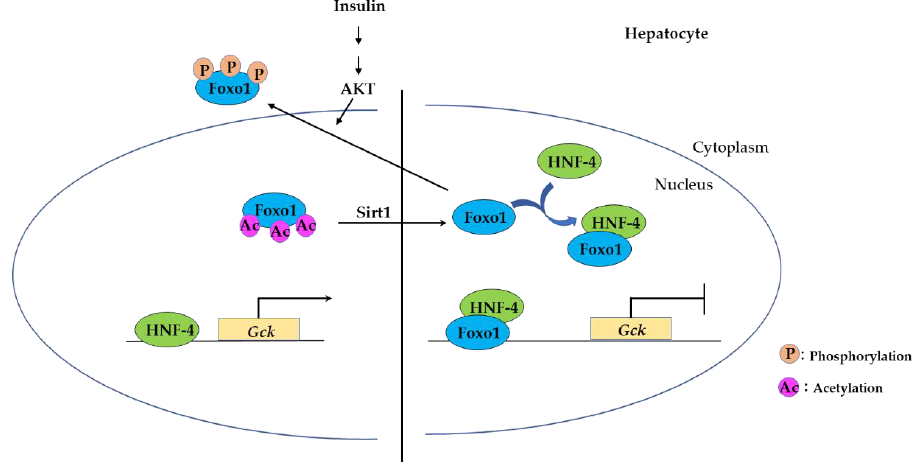
Figure 6. Foxo1 binding to hepatocyte nuclear factor (HNF-4) suppresses Gck expression. Gck expression in hepatocyte is tightly controlled not only by Foxo1 – HNF-4 interaction but also by the post-translational modification of Foxo1 acetylation and phosphorylation.